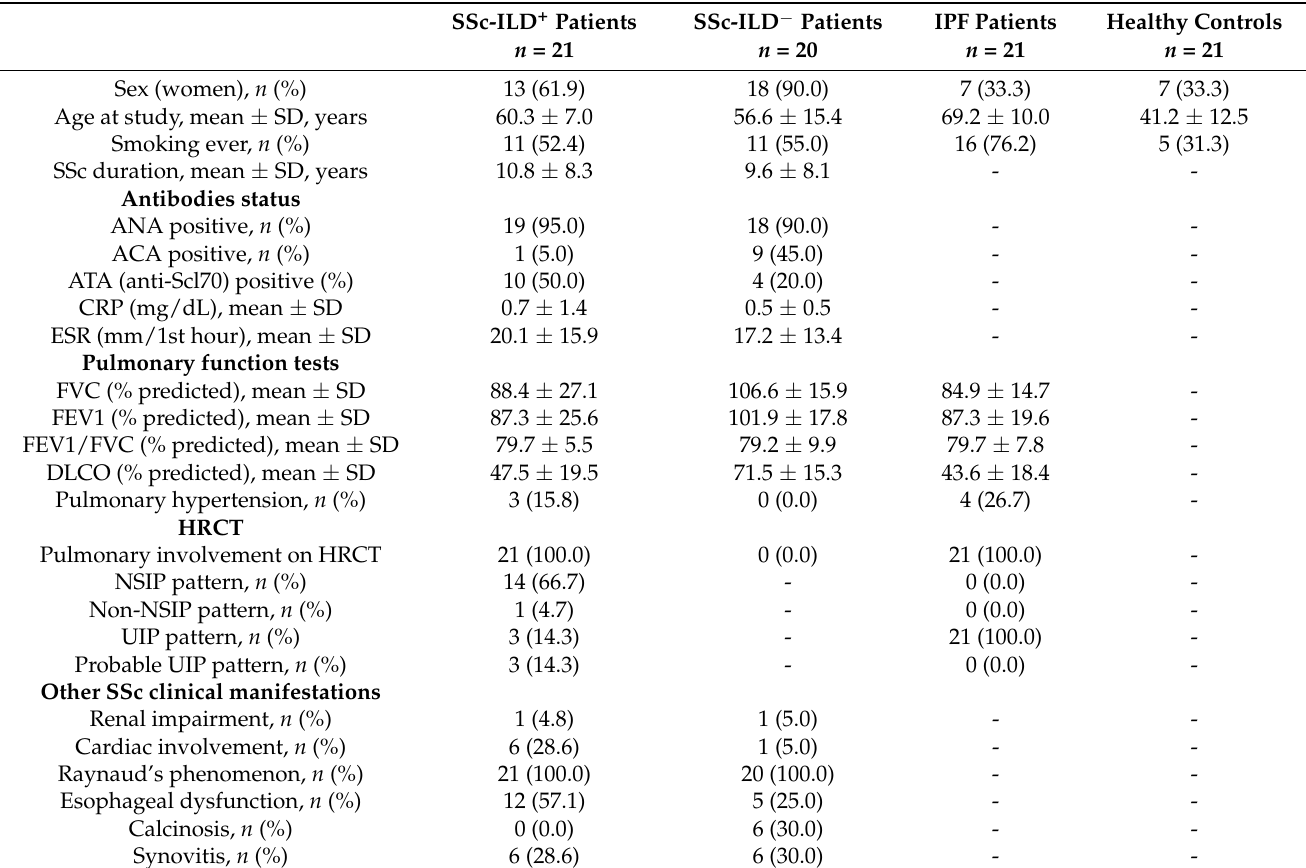
Table 1. Demographic and clinical features of the individuals included in this